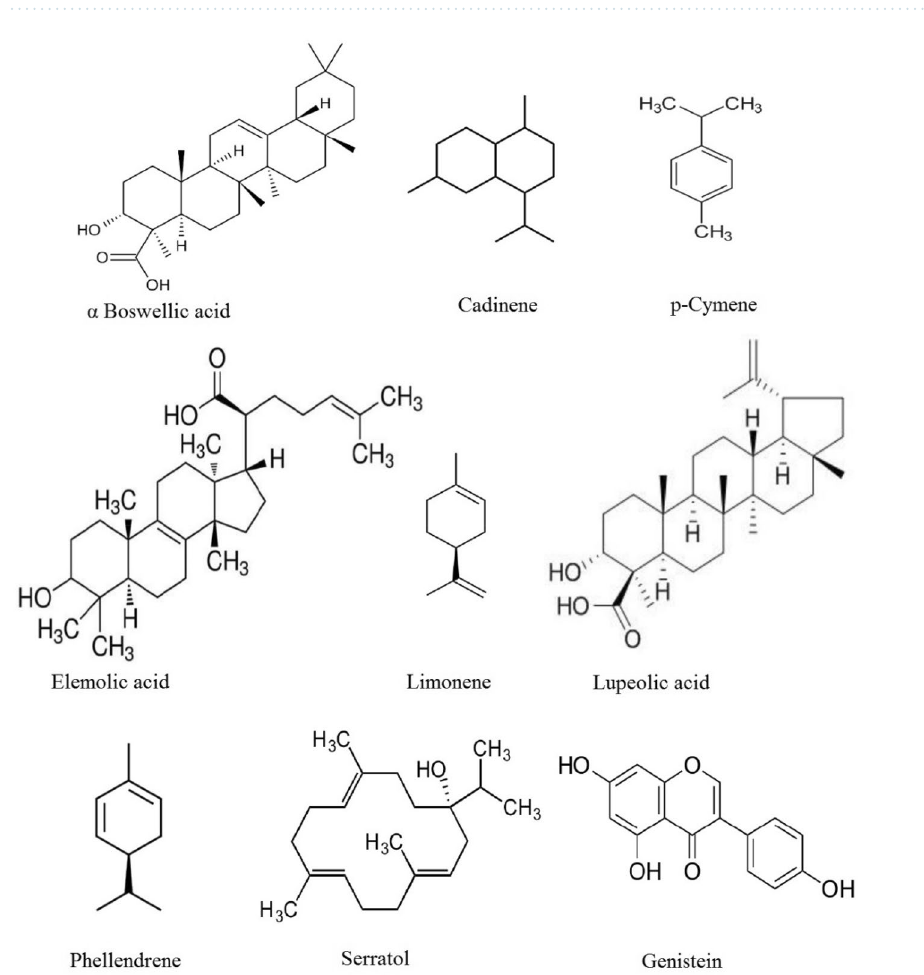
Figure 2. Structures of bioactive compounds from B.